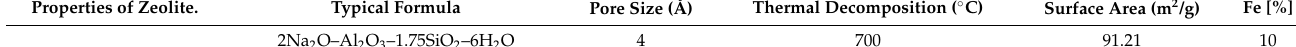
Table 1. Properties of Fe-Zeolite.